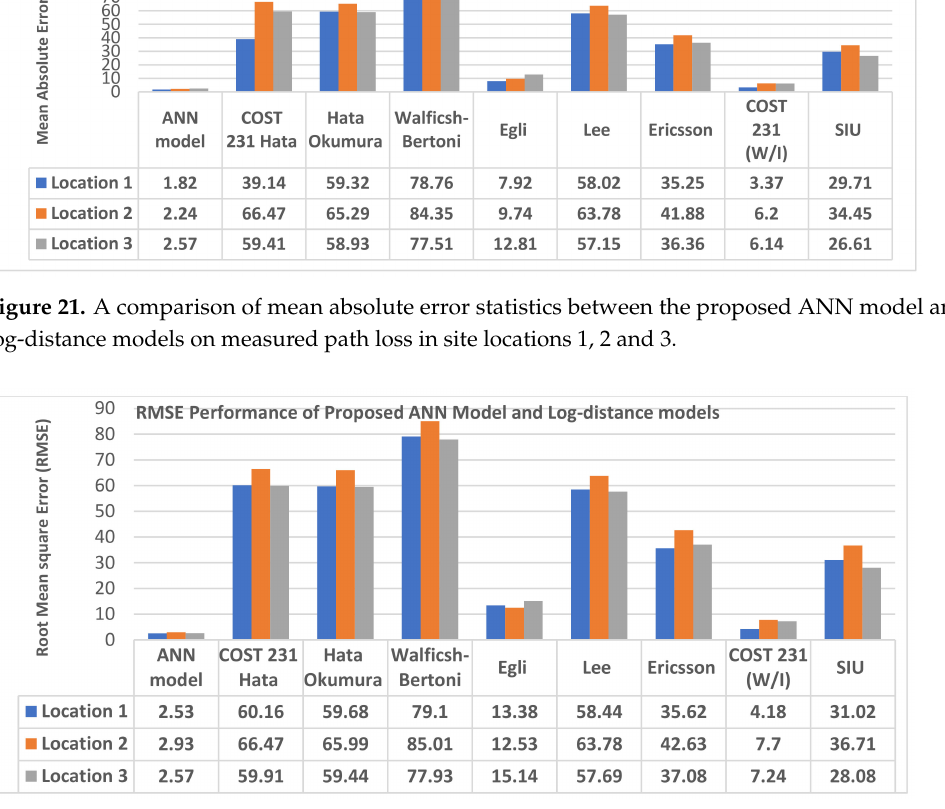
Figure 22. A comparison of root mean absolute error statistics between the proposed ANN model and log-distance models on measured path loss in site locations 1, 2 and 3.